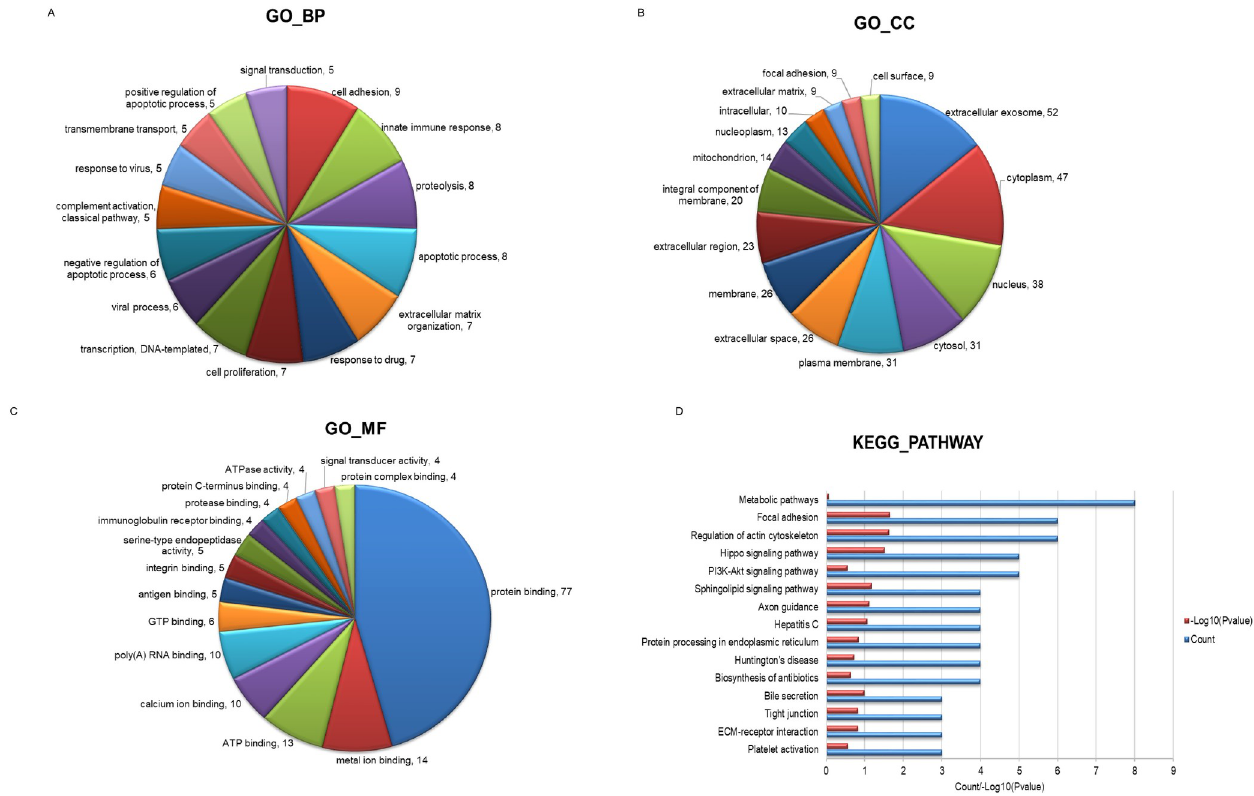
Fig 6. The Bioinformatics analysis of the proteins carried by the sEVs. (A-C) GO functional classification of fibroblast-sEVs proteomes. (A) Biological process, (B) cellular component, and (C) molecular function. The numbers after comma indicate the count of the proteins. (D) The KEGG analysis of the